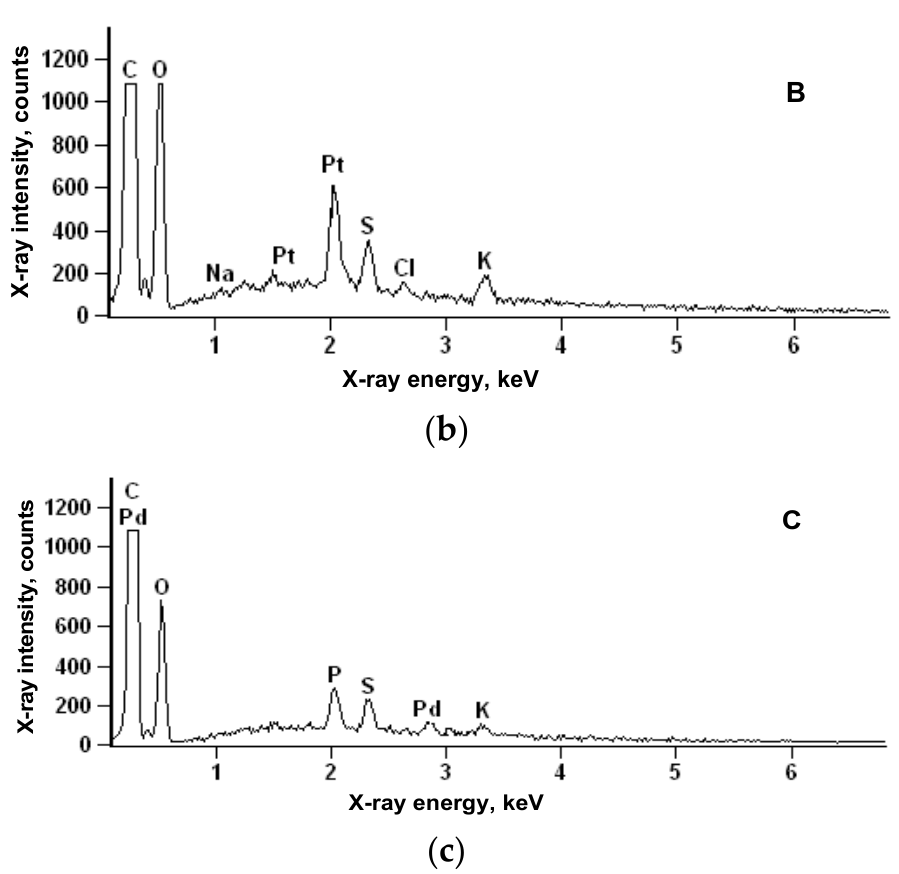
Figure 4. SEM-EDS spectra of ( a ) free fungi cells, ( b ) fungi after incubation with Pt(IV), ( c ) fungi after incubation with Pd(II).